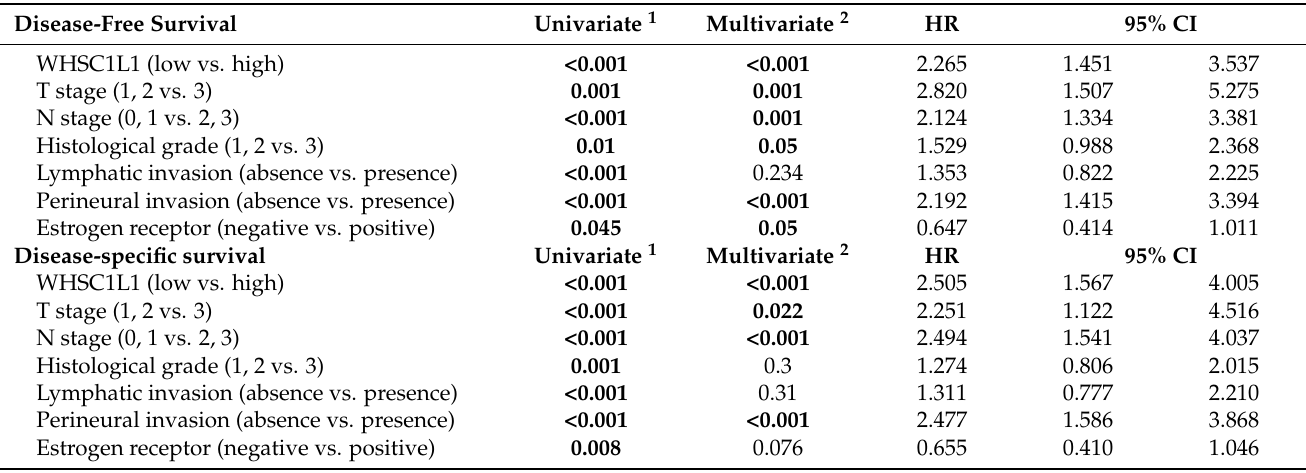
Table 2. Disease-free and disease-specific survival analyses according to WHSC1L1 (Wolf-Hirschhorn syndrome candidate 1-like protein 1) in HYGH